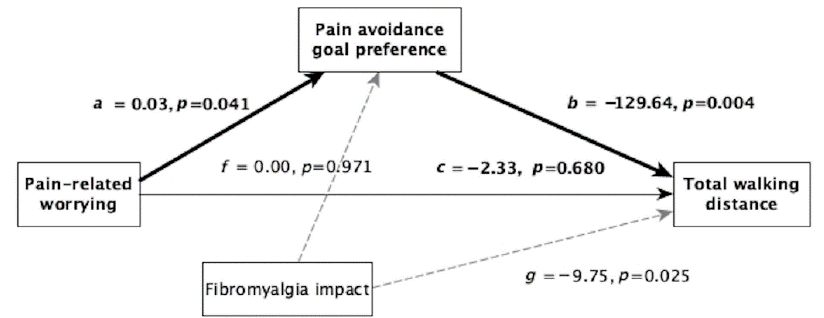
Figure 2. Paths linking pain-related worrying and total walking distance.